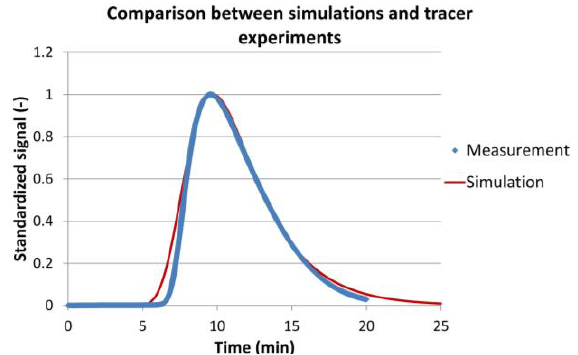
Figure 7. Comparison between simulations (red line) and tracer experiments (blue dots) for a volumetric flow of 0.5 mL/min.